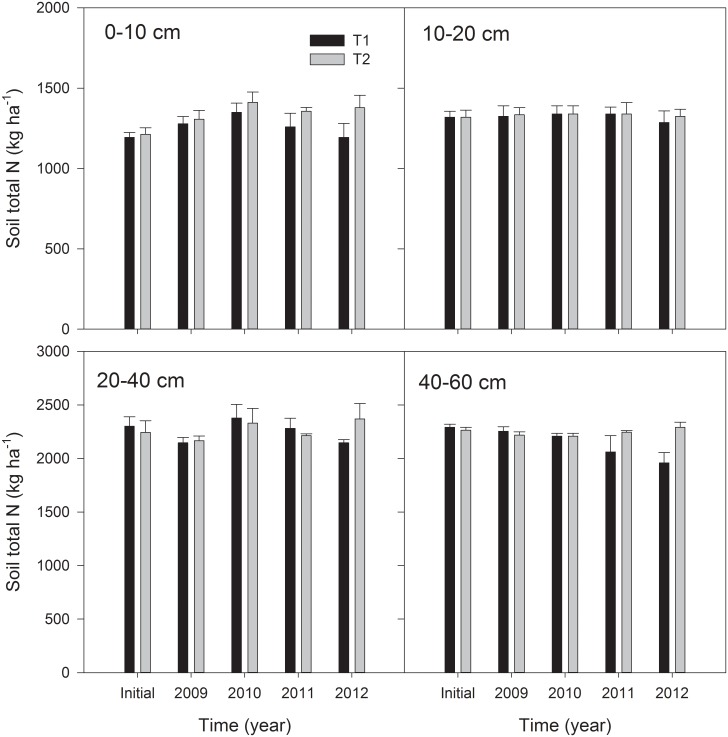
Changes in soil total N content for four soil layers (0–10, 10–20, 20–40, and 40–60 cm) under different treatments during 2009 to 2012.Error bars mean standard deviations, n = 3.